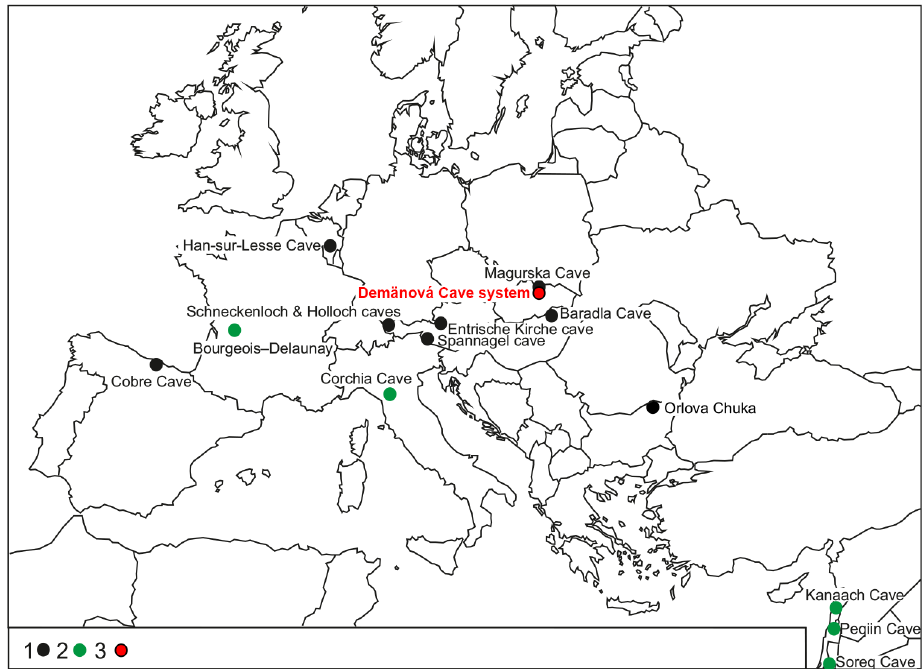
Figure 5. The locations of the European and Middle Eastern MIS 5–MIS 6 speleothem sites. The numbers used in the panel legend refer to the following: 1 – speleothems with temperature as a dominant factor influencing the δ 18 O value, 2 – speleothems for which the changes in the isotopic composition of rainwater and the amount of precipitation are dominant factors influencing the δ 18 O value and 3 – the study